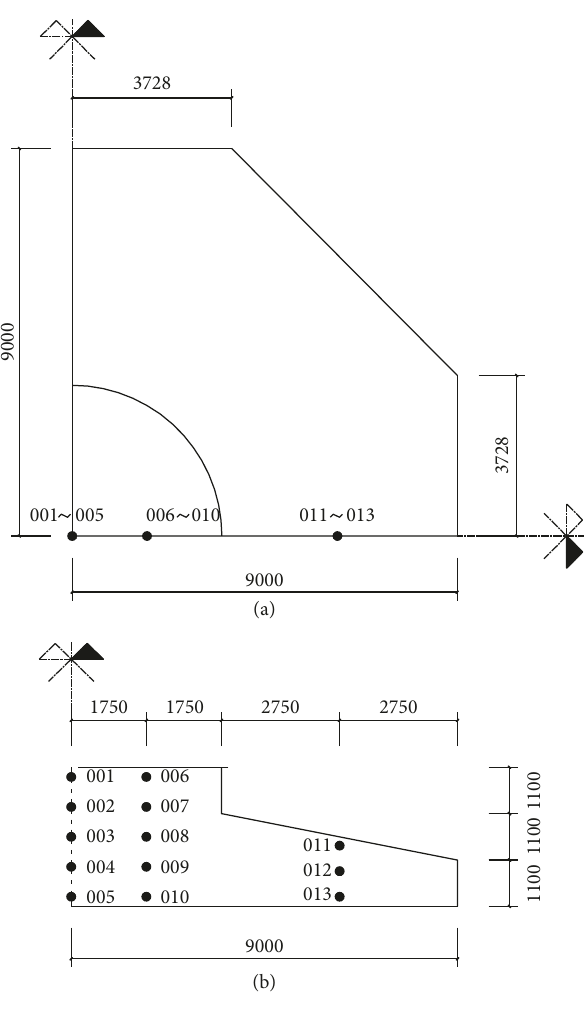
Figure 2: Layout of the temperature sensors: (a) top view and (b) side view.